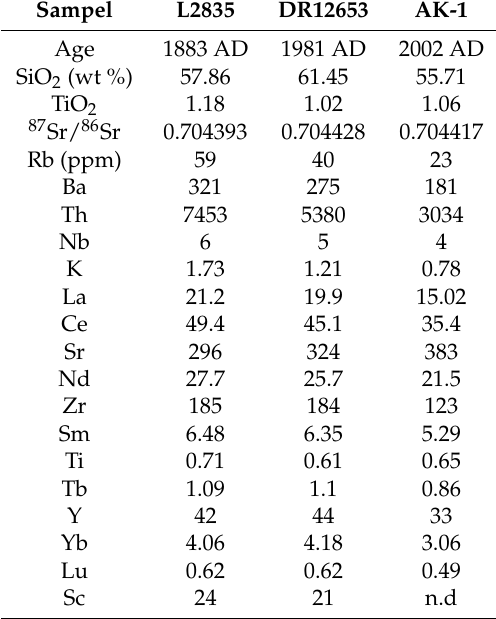
Table 1. Major, trace and rare earth elements, as well as Sr isotopes, from 1883, 1981 and 2002 AD eruption products. Data source 2002 from [6], 1883 and 1981 from [7]. Note: n.d means not determined. Sampel